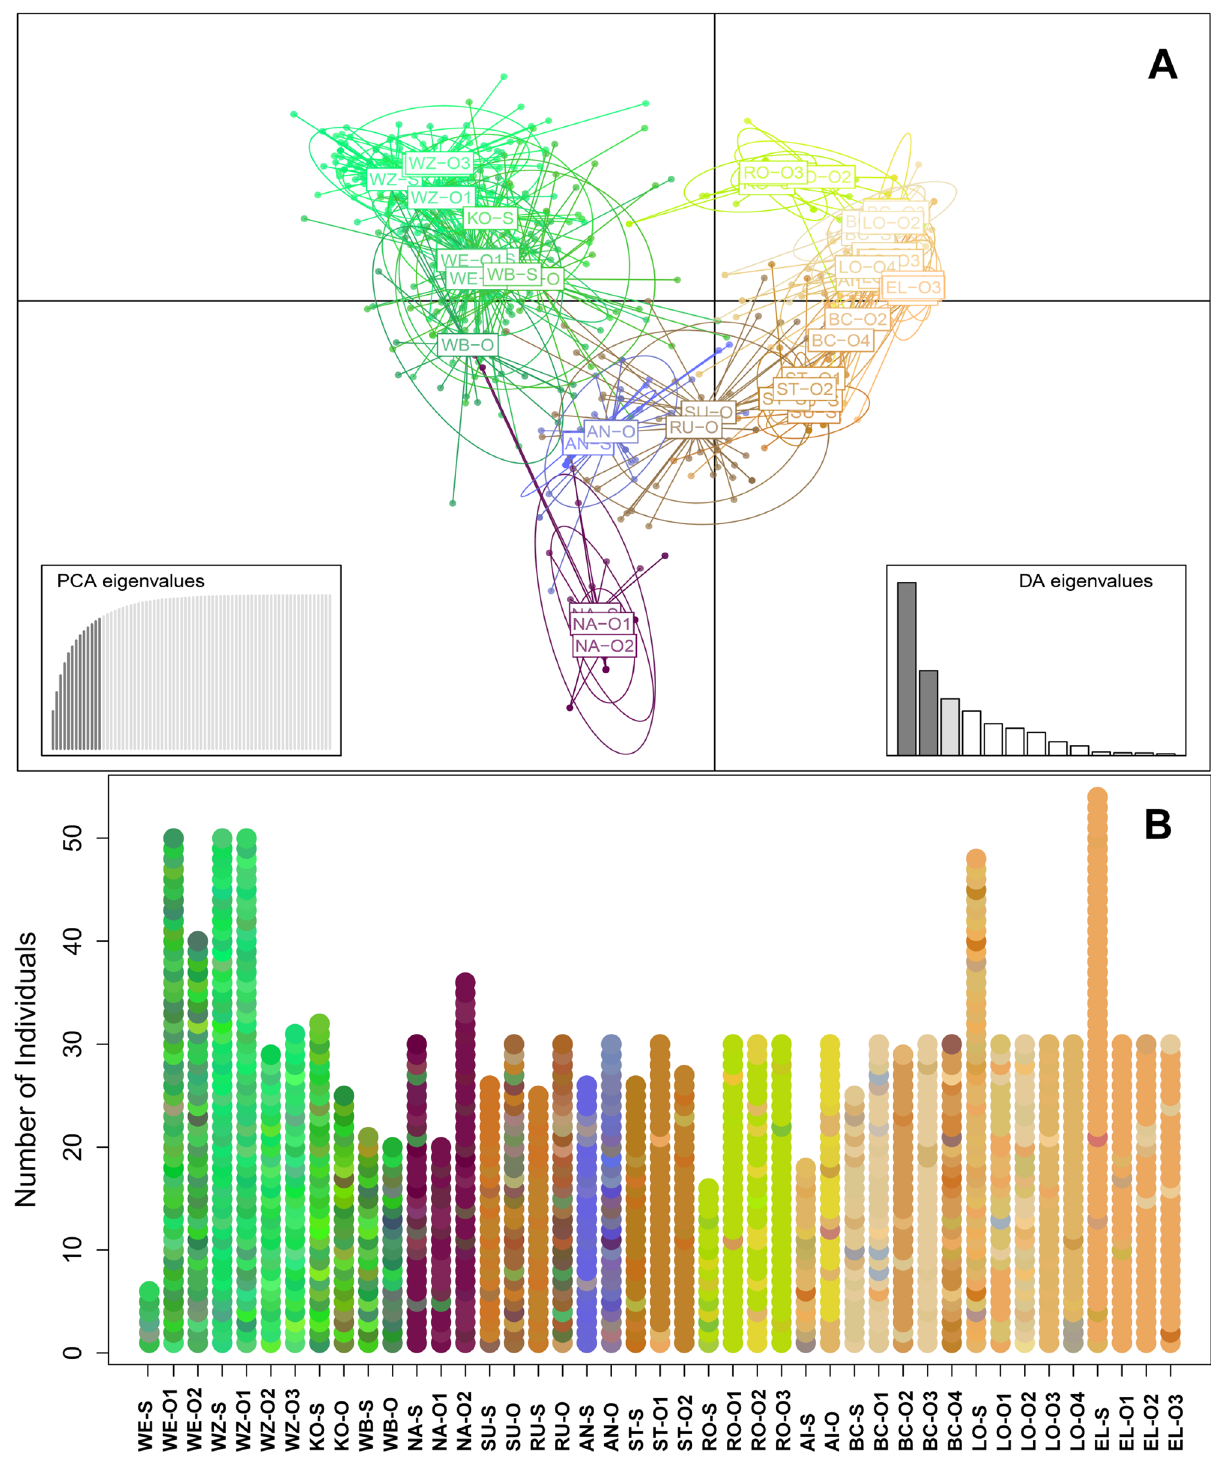
Figure 1. ( A ) Clustering of 1300 individuals of 14 Margaritifera margaritifera source populations and 29 corresponding cohorts of propagated juveniles based on discriminant analysis of principal components (DAPC) using the first 13 principal components and 3 discriminant functions. Individuals are depicted as dots, populations are represented by inertia ellipses and mean population color based on the DAPC; population codes according to Table 1. ( B ) Individual genetic constitution of 1300 Margaritifera margaritifera from 14 source populations and respective cohorts of propagated juveniles based on discriminant analysis of principal components (DAPC) using the first 13 principal components and 3 discriminant functions. The color of the dots corresponds to the results of the DAPC with similar colors indicating similar genetic